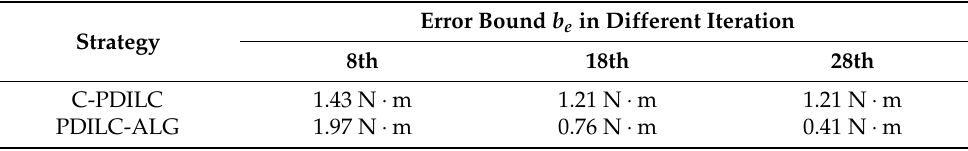
Table 3. Case 1 ( θ ∗ a ( t ) = 8 ◦ sin ( 2 π ih ) , y d ( t ) = 30sin ( 2 π ih ) ) experimental results of the two